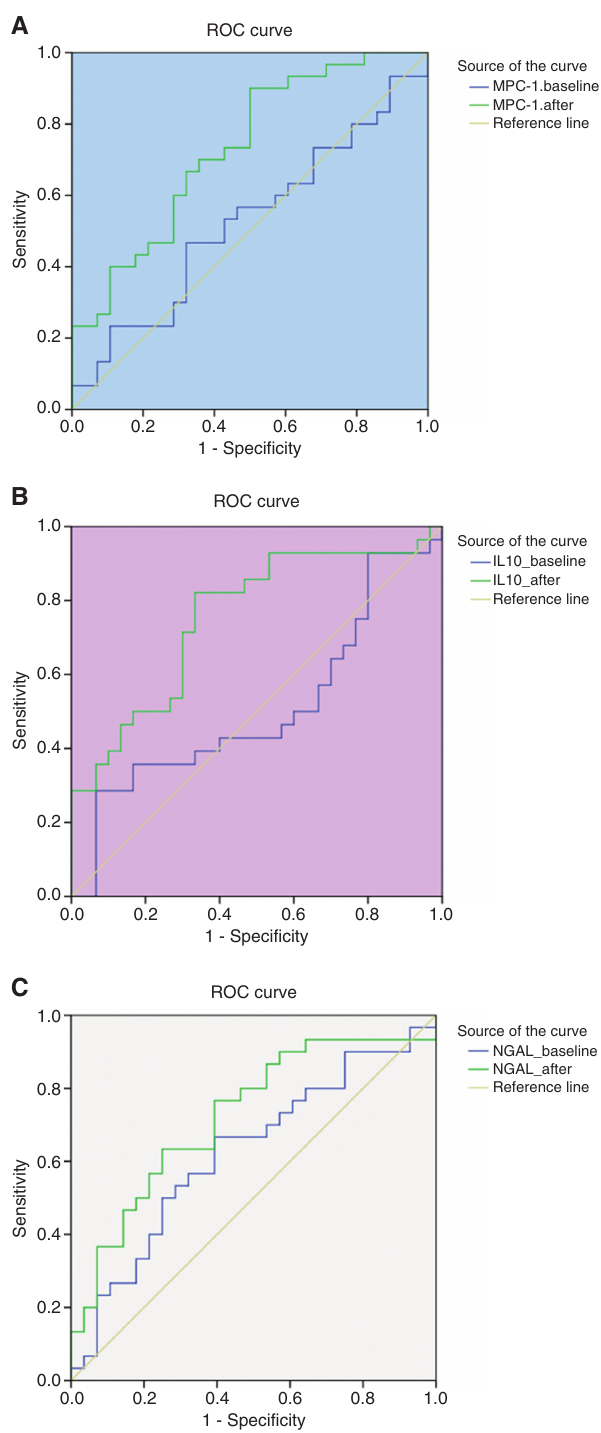
Figure 1: ROC profiles for (A) MPC-1, (B) IL-10 and (C)